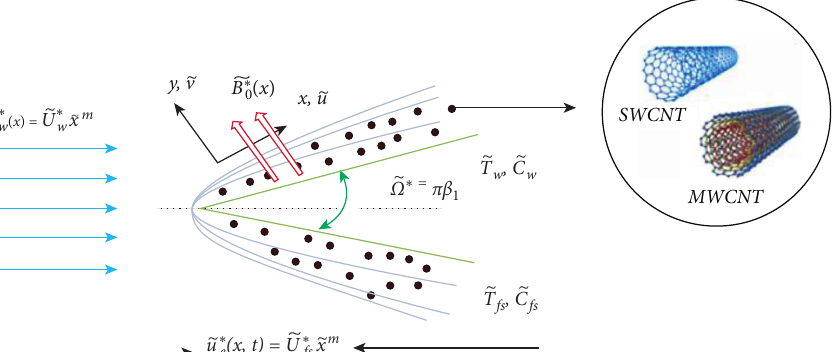
Figure 1: Physical interpretation of flow